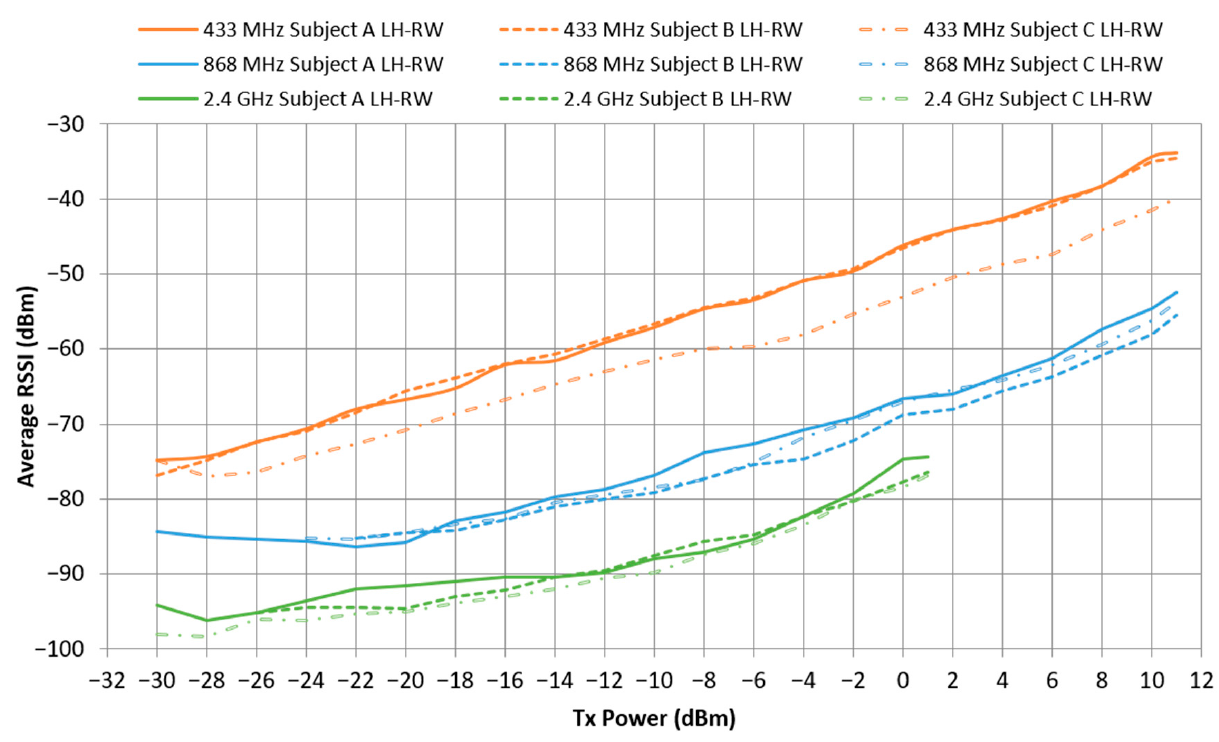
Figure 12. Average RSSI in the walking scenario for all subjects and frequencies: sender node located on the right wrist.